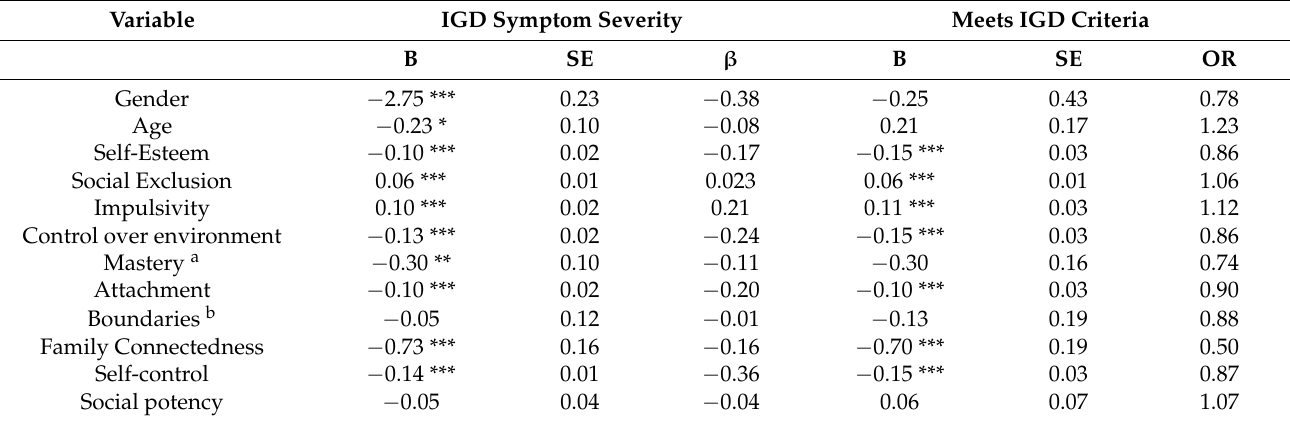
Table 2. Univariate regression analyses for IGD symptom severity and